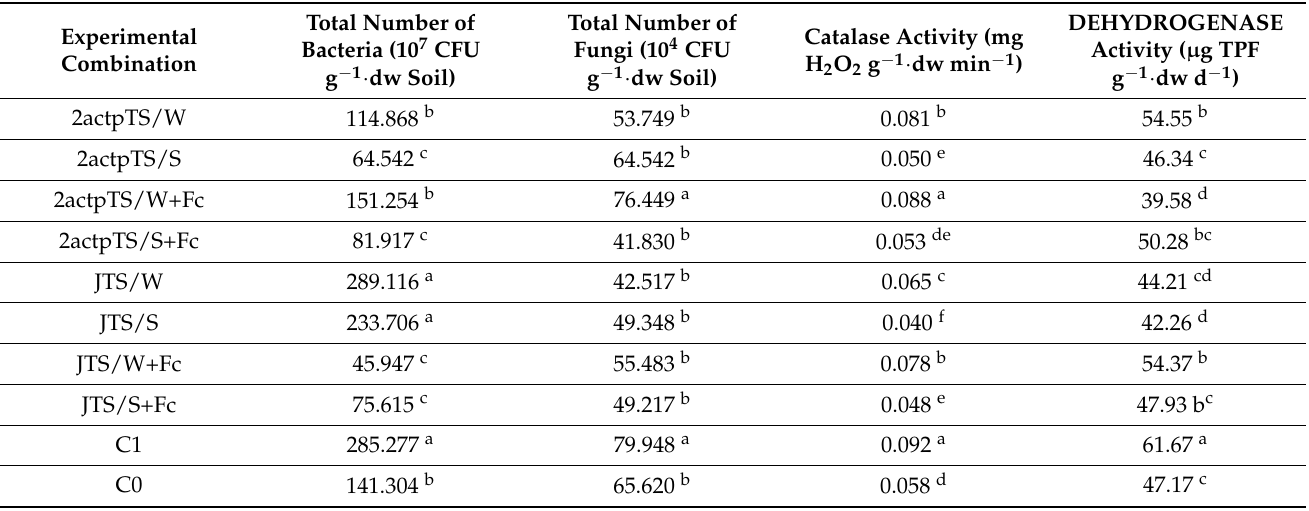
Table 2. Biological activity of the soil with wheat seedlings ( Triticum aestivum L.) after application of 2actpTS and JTS molecules.